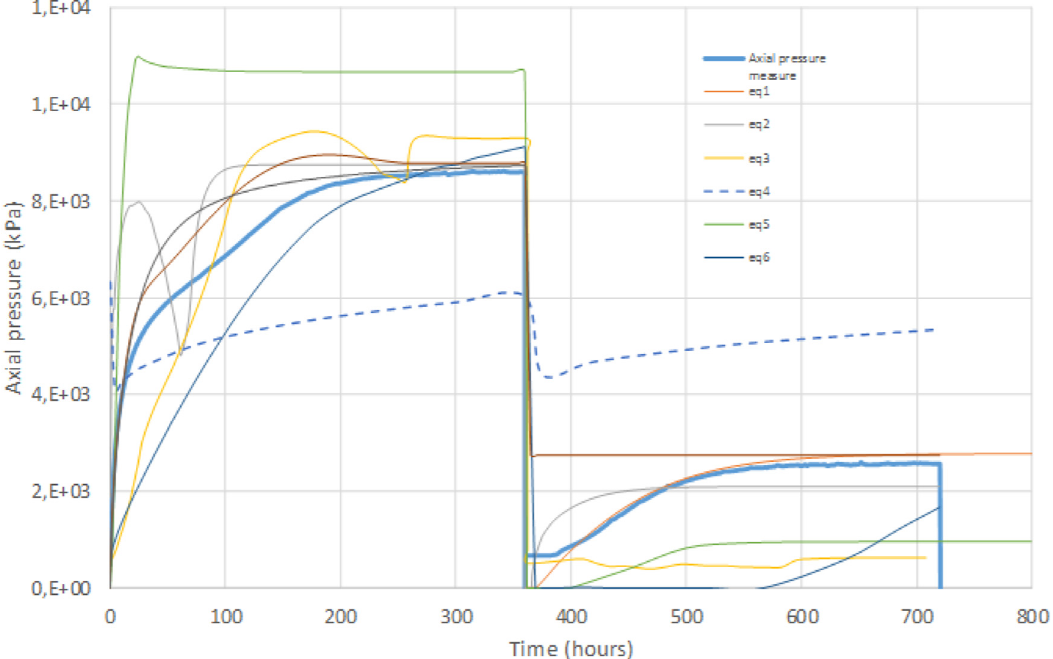
Fig. 8. Axial pressure evolution (cid:1) comparison between the experiment and the